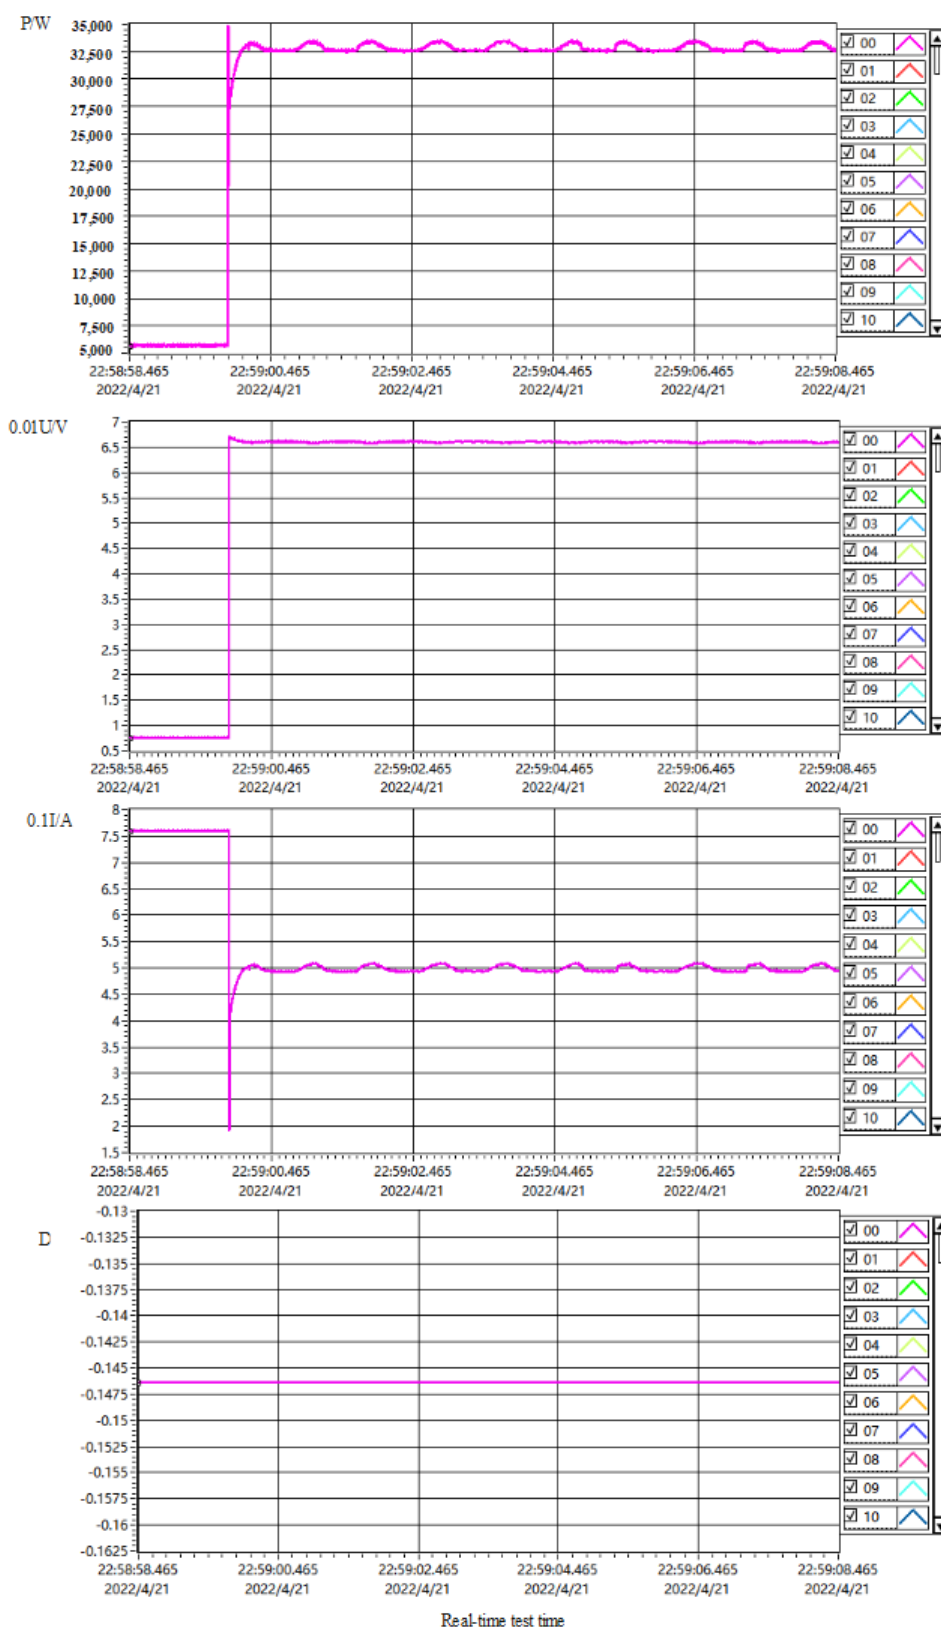
Figure 18. 1BWO output curves based on real-time simulation Figure 18. 1 BWO output curves based on real-time simulation platform.